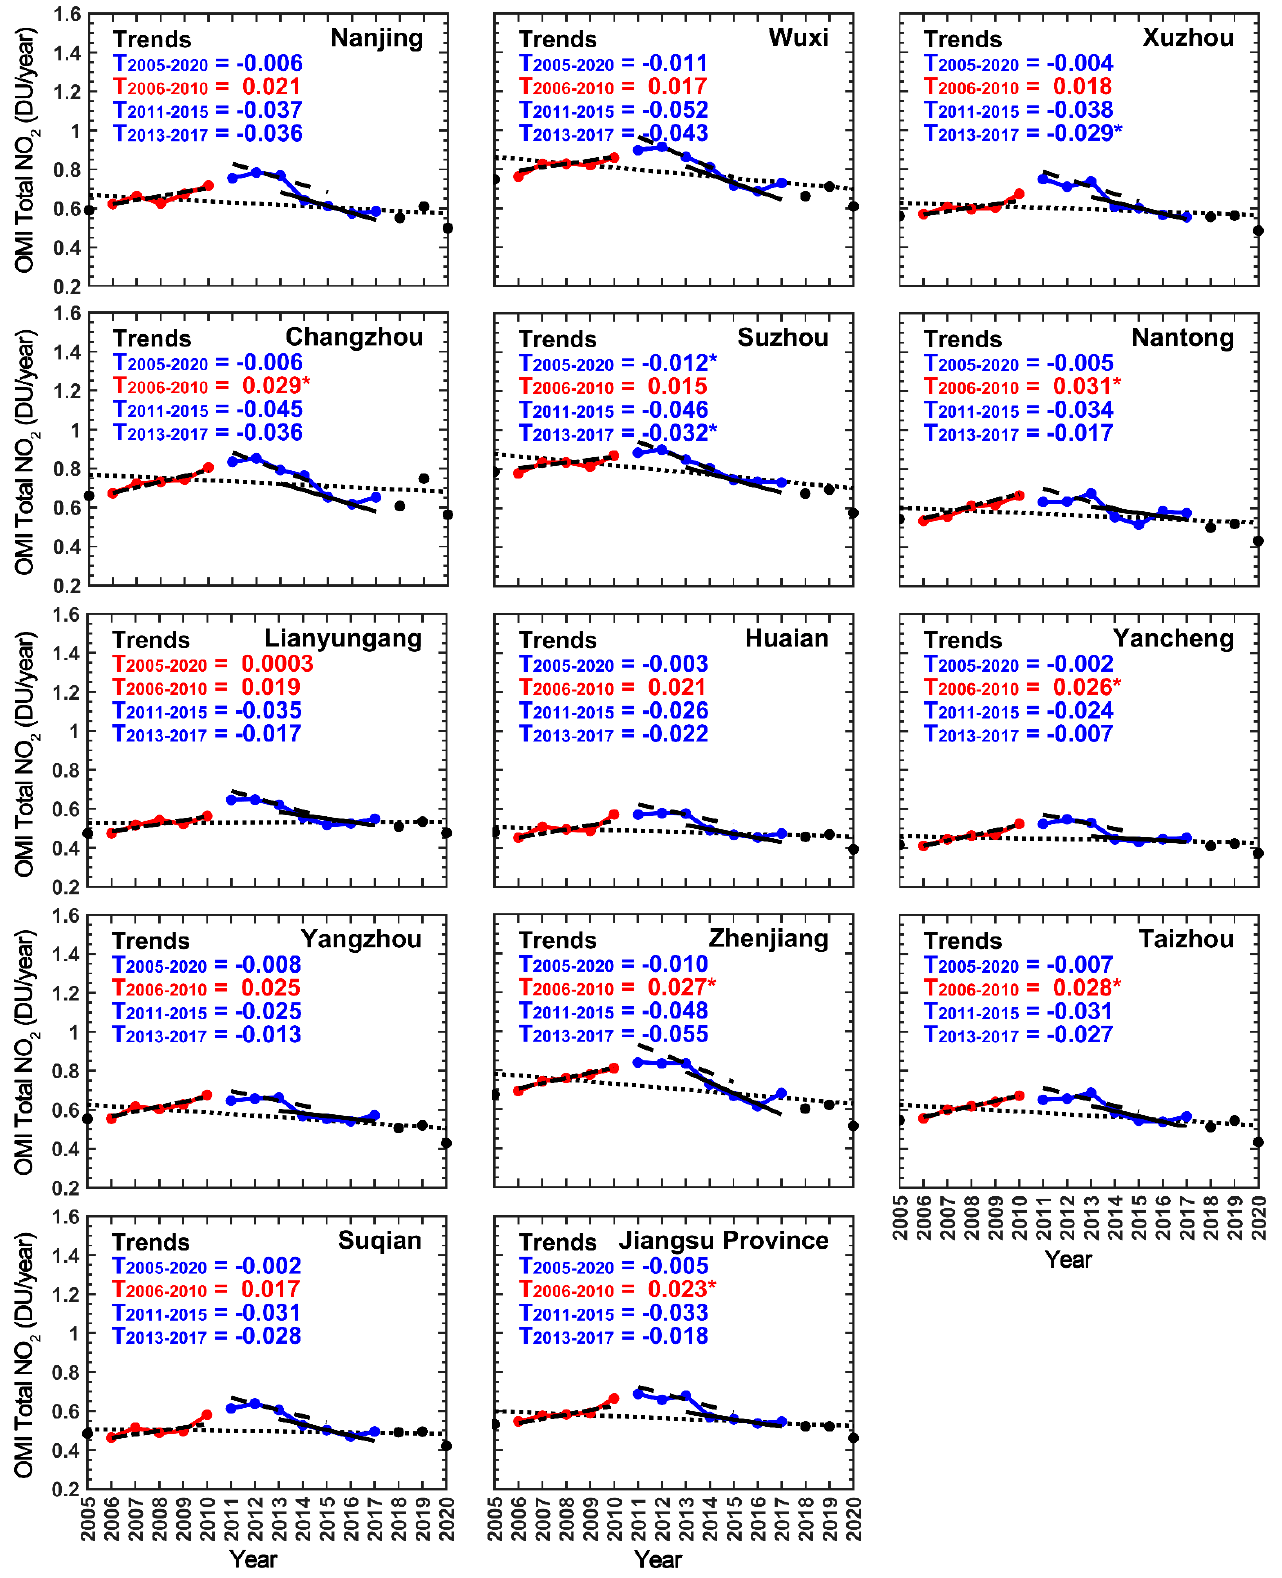
Figure 7. Trends in NO 2 (DU/year) for the periods of 2005 − 2020, 2006 − 2010, 2011 − 2015, and 2013 − 2017 in 13 cities of Jiangsu Province. The red color indicates an increasing trend, and the blue color indicates a decreasing trend in NO 2 . The asterisk (*) indicates significance.